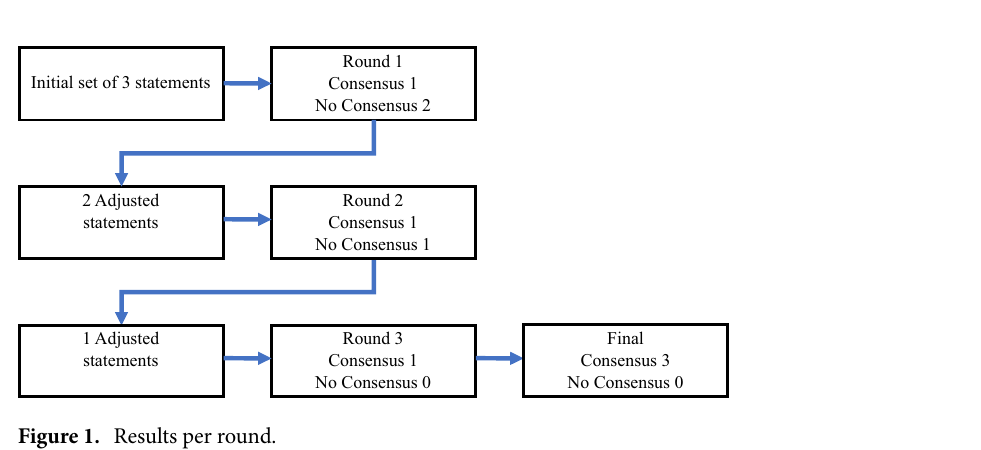
Figure 1. Results per